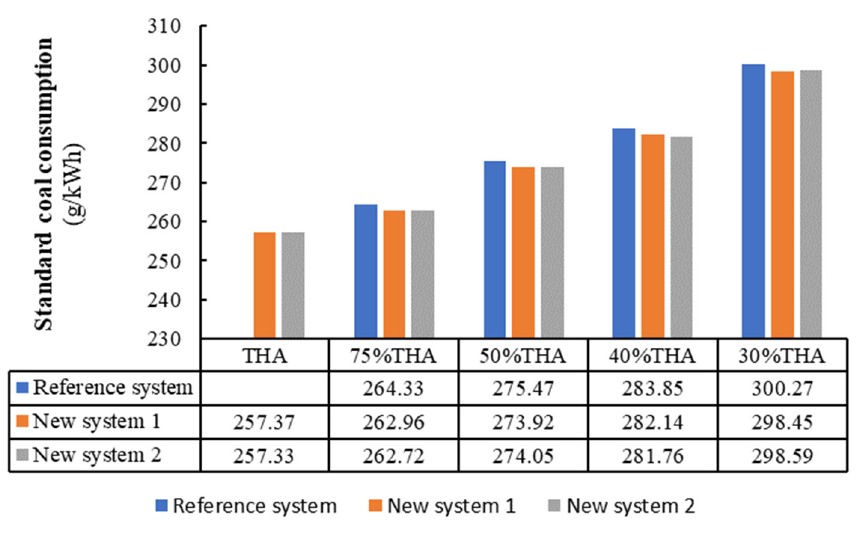
Figure 12. Coal consumption rates of new systems and reference system.